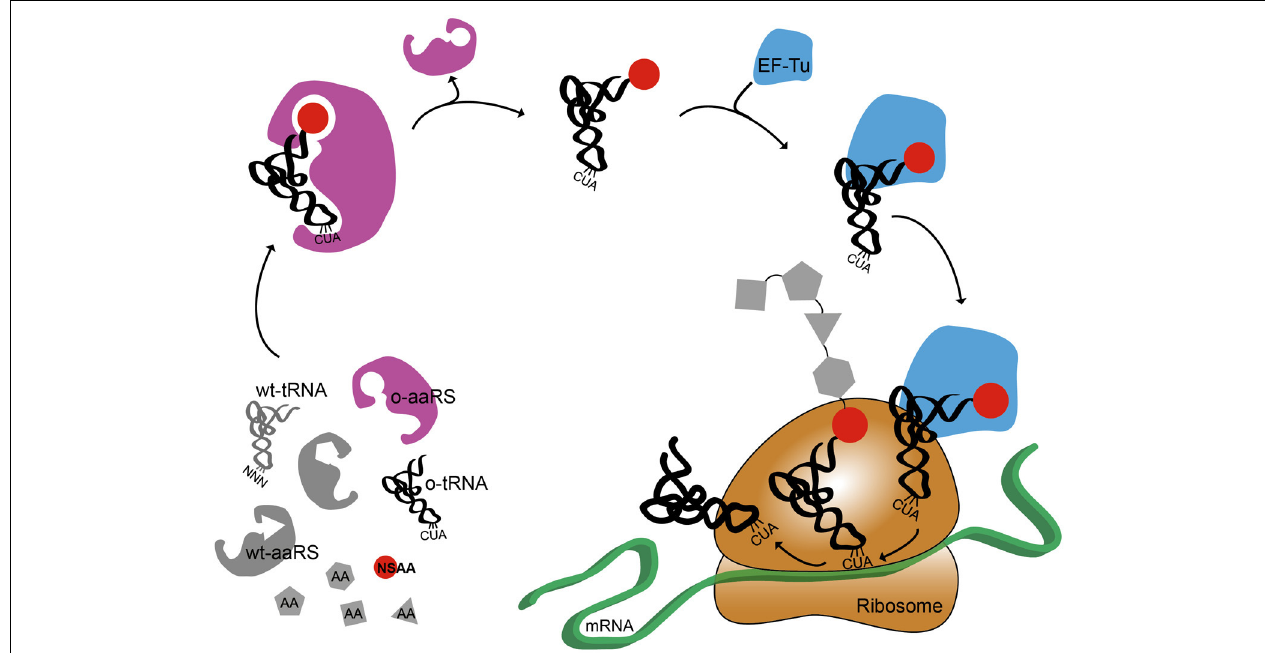
FIGURE 1 | Schematic representation of non-standard amino acid incorporation using an orthogonal translation system. Orthogonal aminoacyl tRNA synthetase, o-aaRS; orthogonal tRNA, o-tRNA; wild-type aminoacyl tRNA synthetase, wt-aaRS; wild-type